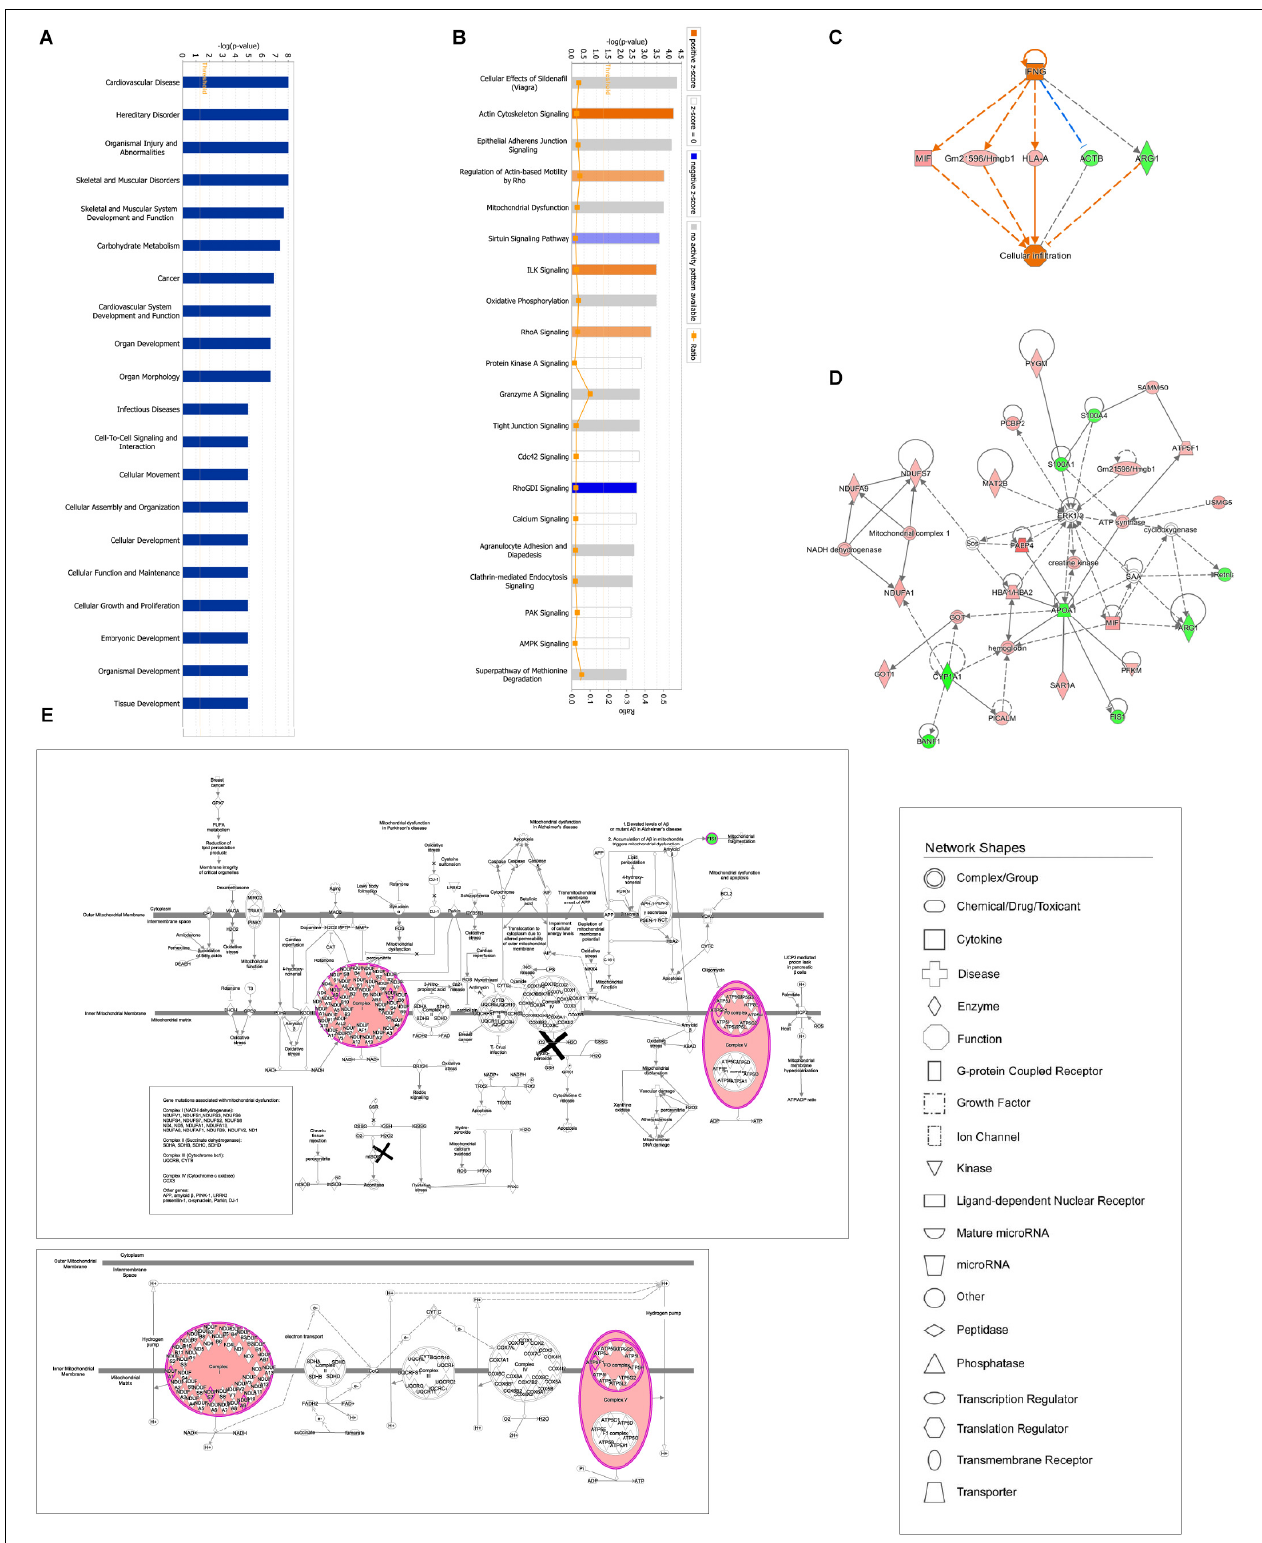
FIGURE 4 | Bioinformatic analysis of DEPs in the lung after GBFXD treatment. (A) Biological function enrichment. (B) The most enriched pathways as a summary of DEPs between the GBFXD and model groups. (C) Regulatory effects resulting from integrating target molecules, upstream factors, and downstream biological functions. (D) The most credible interaction networks. (E) IPA of mitochondrial function and the oxidative phosphorylation pathway.